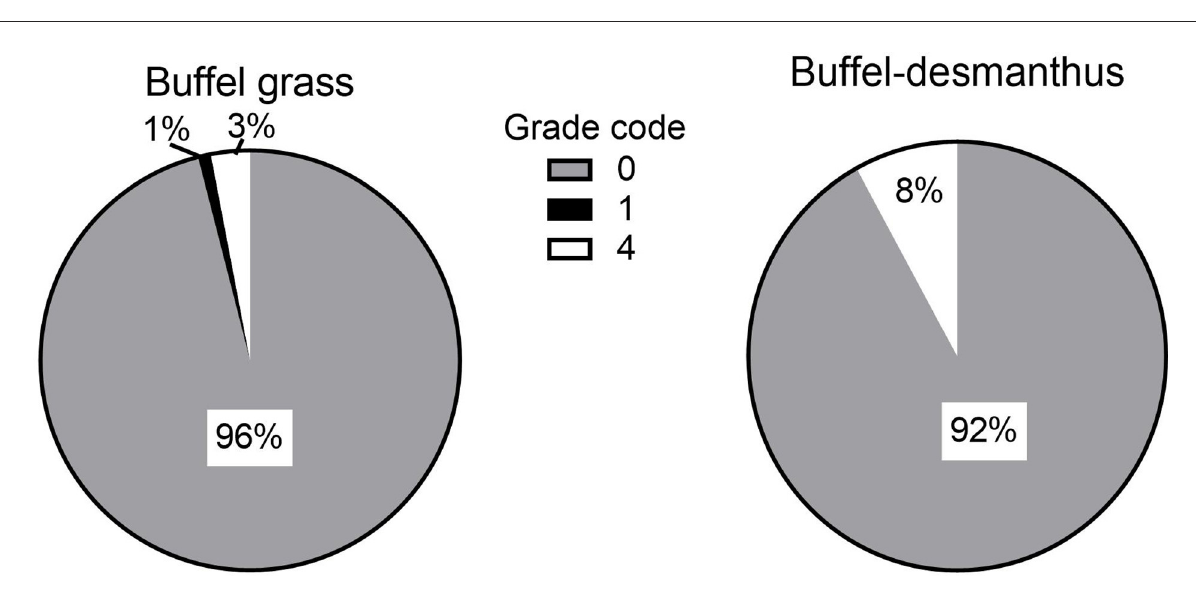
FIGURE3 Effect of backgrounding pasture on steer carcass grade ( p =